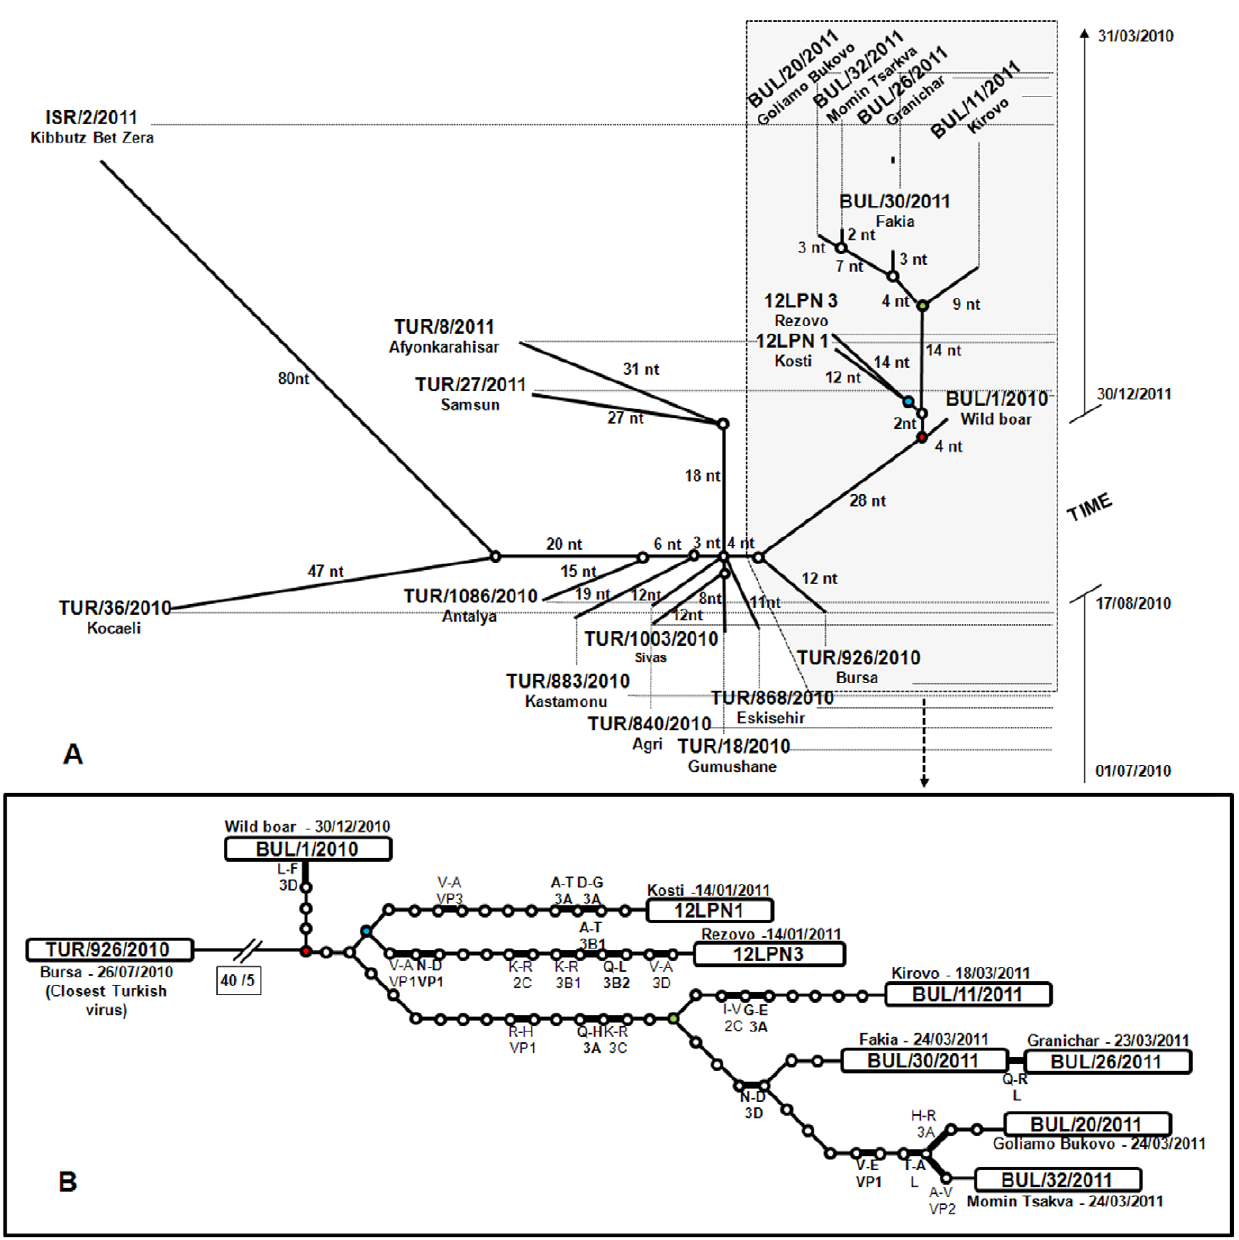
Figure 3. Statistical parsimony trees as implemented by TCS using the full genomes of 19 sequenced FMDVs. A . Edited TCS tree in which putative virus ancestors ( # ), except those corresponding to nodes, were removed. The length of the branches is directly proportional to the number of nucleotide (nt) changes. The vertical axis represents a time scale which denotes the date when the viruses were collected. B . Detailed TCS tree showing the viruses corresponding to the Bulgarian outbreaks and their closest ancestor within the Middle East. Open circles and lines correspond to putative genetic intermediates separated by single nt changes. Putative common (red circle) and secondary ancestors for each wave are shaded (blue circle, first; green circle, second). Lines in bold correspond to non-synonymous changes. The square shows the number of nt versus non-synonymous changes. The specific amino-acid changes are indicated, as well as the viral proteins involved. Non-conservative amino-acid substitutions (according to GONNET matrix, as implemented in BioEdit software) are highlighted in